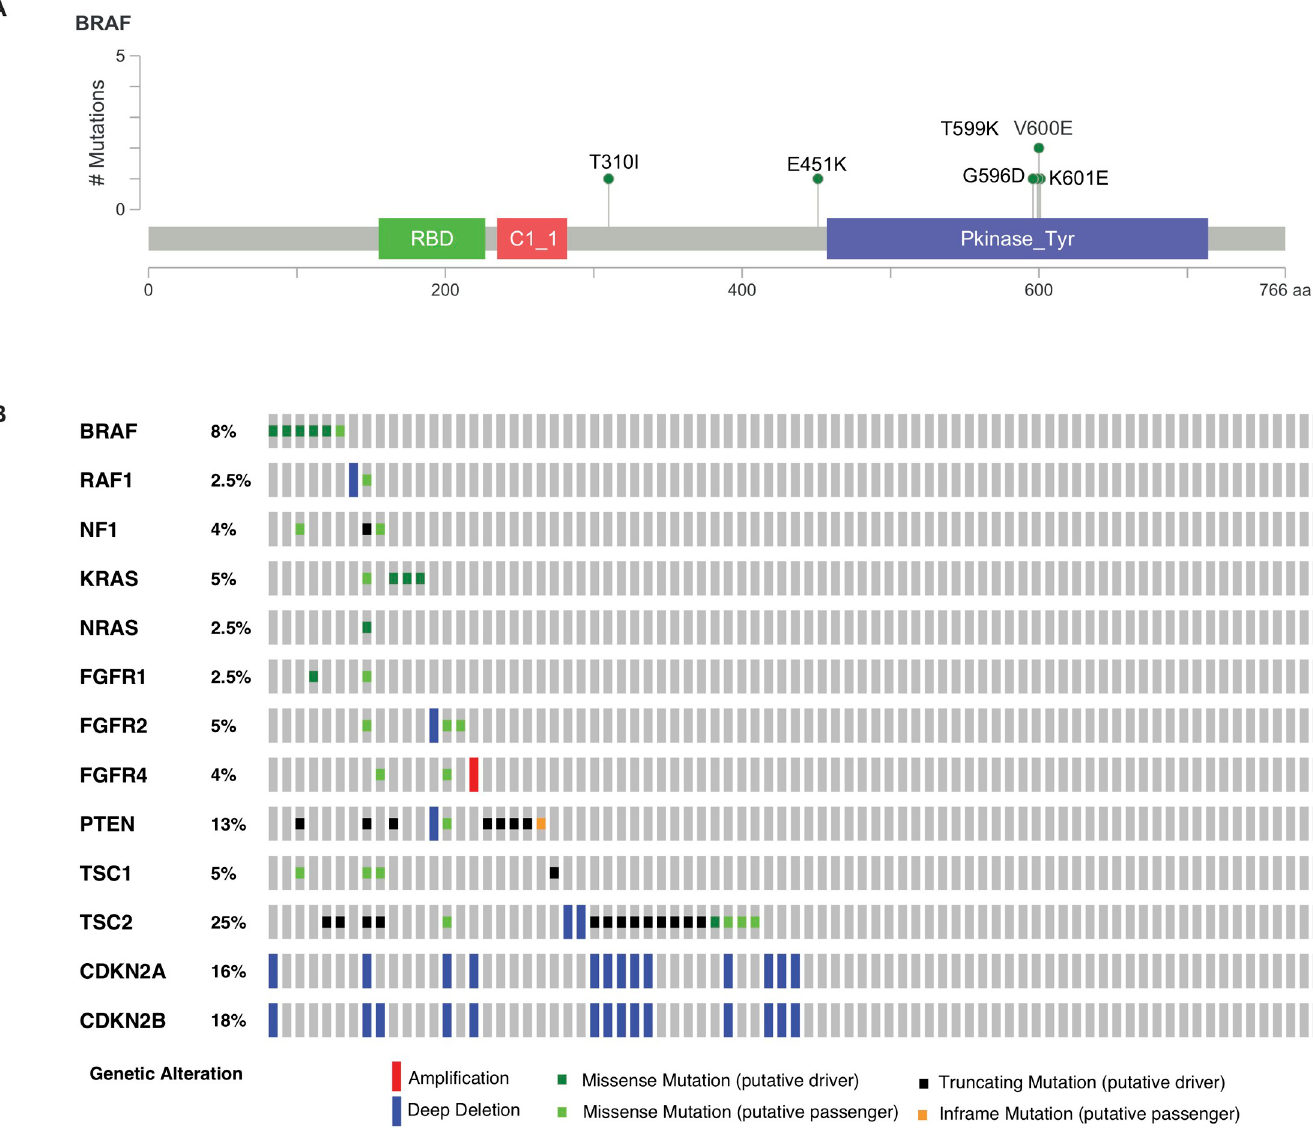
Fig 1. Identification of BRAF mutations in the MSK-IMPACT clinical series of panNET. A. Lollipop plot demonstrating BRAF mutations identified by MSK-IMPACT in our series of panNET. B. Identification of RTK/ RAS/ RAF/ PI3K pathway mutations in MSKCC clinical series of panNET (n = 80). First two columns/ samples represent tumors with BRAF V600E. (Complete list of genes included in query is included in S1 Methods. Genes for which no mutations were identified are not shown in the plot.)